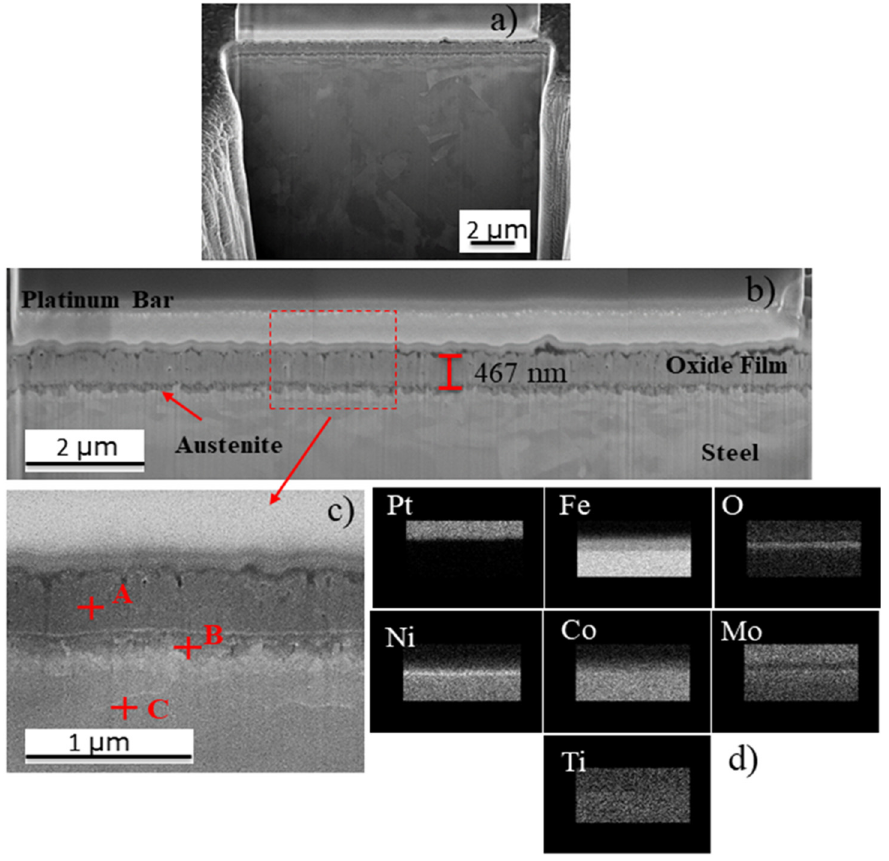
Figure 7. Scanning electron microscope (SEM) micrographs of the oxide layer formed in maraging 300 alloy, ( a ) focused ion beam (FIB)-cross section micrograph of the oxide layer, ( b ) thickness of the oxide layer, ( c ) magnification of the oxide layer showing the three different points where the chemical composition were determined, and ( d ) energy-dispersive X-ray spectroscopy (EDS) maps analysis for different metallic elements present in the oxide later (Fe, O, Ni, Co, Mo and Ti) in the region described in ( c ). Table 4. Energy-dispersive X-ray spectroscopy (EDS) measurements for the three different points shown in Figure 7d.